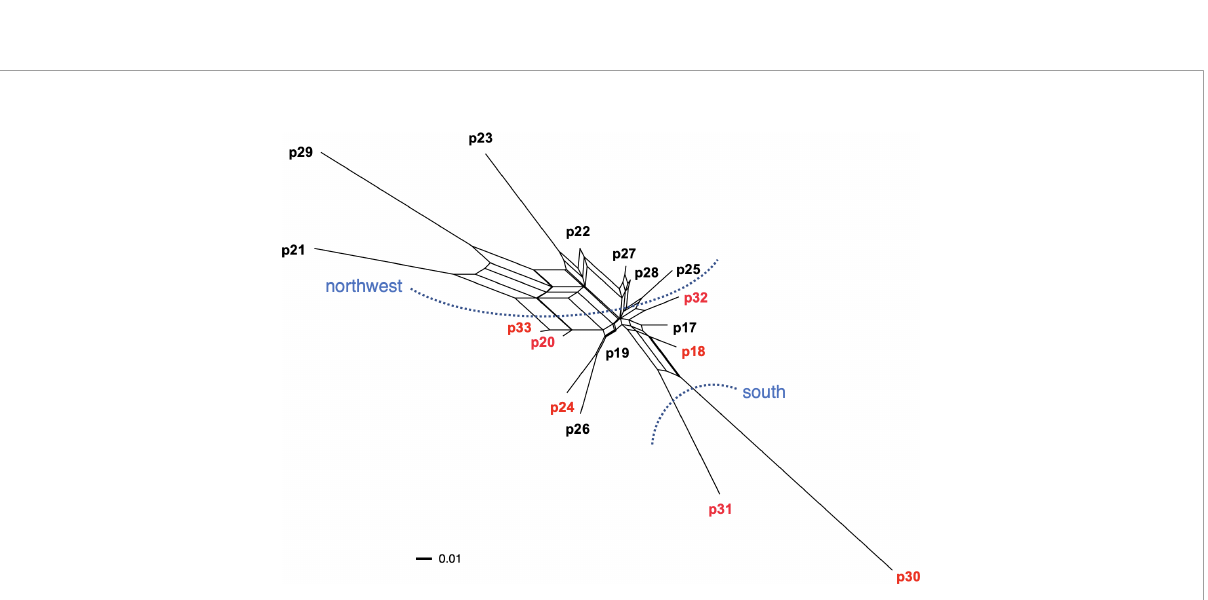
FIGURE 8 Phylogenetic network among populations within Okushiri Island based on pairwise genetic distance. Population numbers are identical to Figure 1 and Supplementary Table 1. Two distinguished localities, south and northwest, are indicated by blue dotted lines. Population in red letters include cpDNA haplotype A.